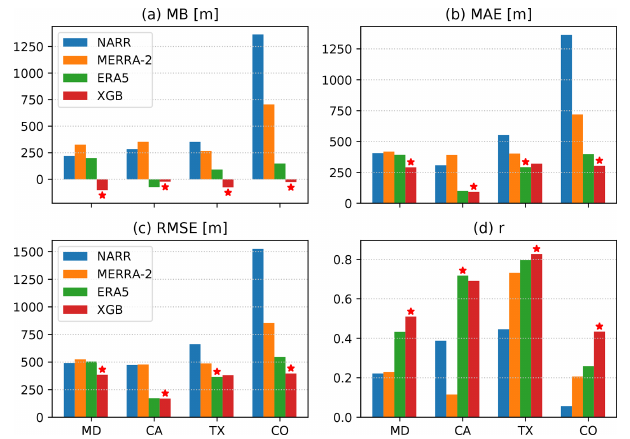
Figure 10. Similar to Fig. 9 but using the PBLH labeled from spiral profiles during four DISCOVER-AQ